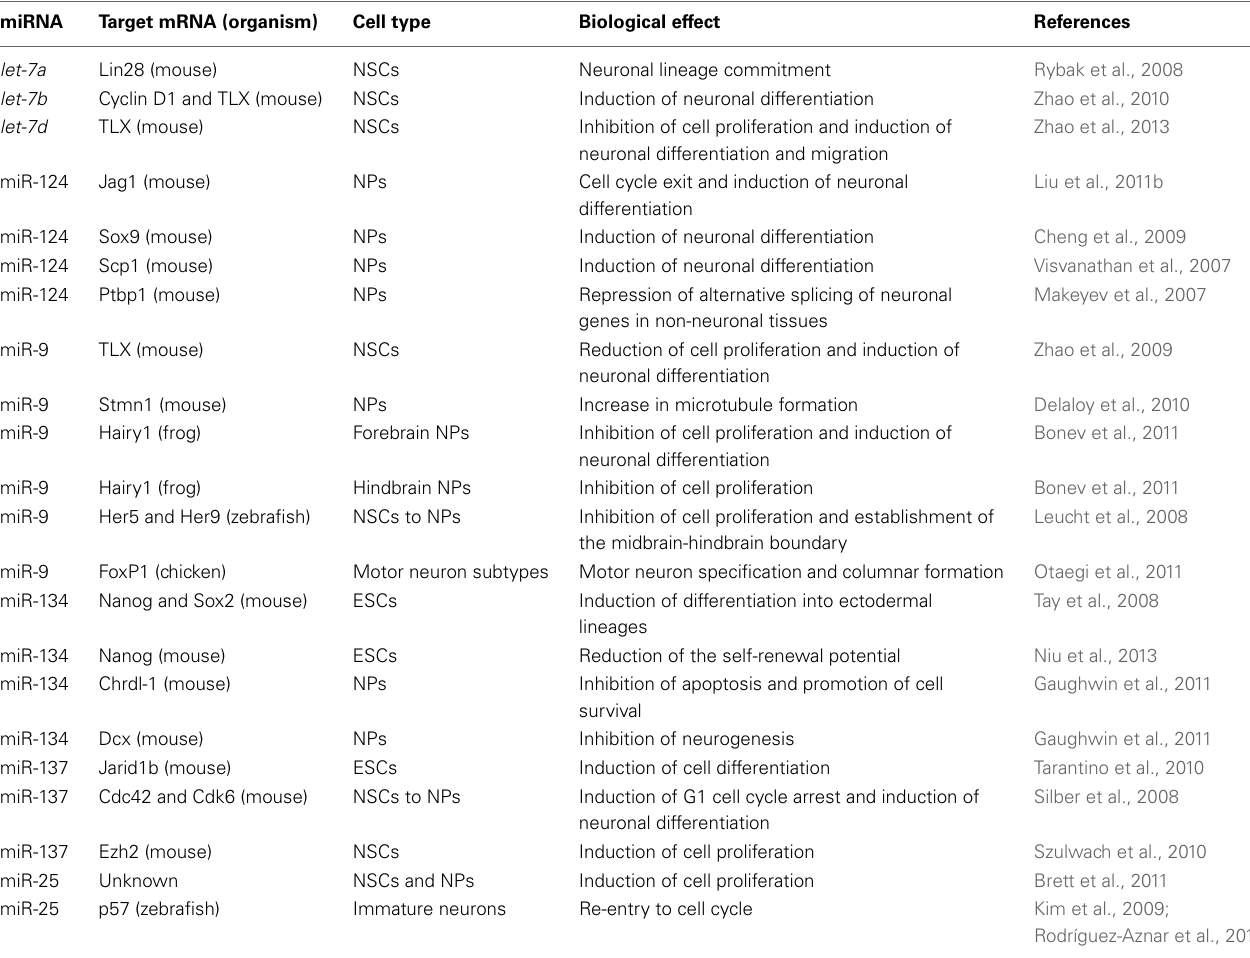
Table 1 | miRNAs involved during early neuronal differentiation.